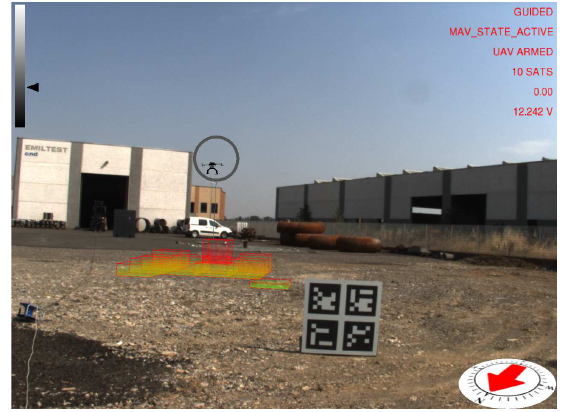
Figure 18. Simulated environment developed for the usability tests. The UAV is a 3D model simulated using the ArduCopter SITL simulator.